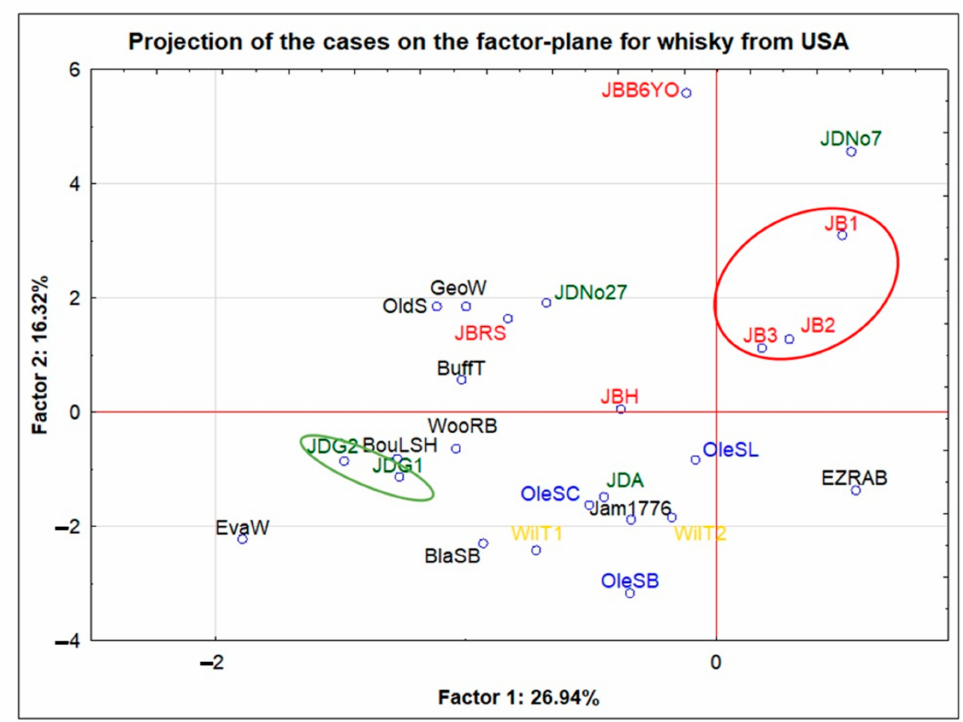
Figure 1. Projection of the cases on the factor-plane for 25 samples (after scale change) from the USA. The JDG1 and JDG2 (samples from independent bottles of JDG—marked in